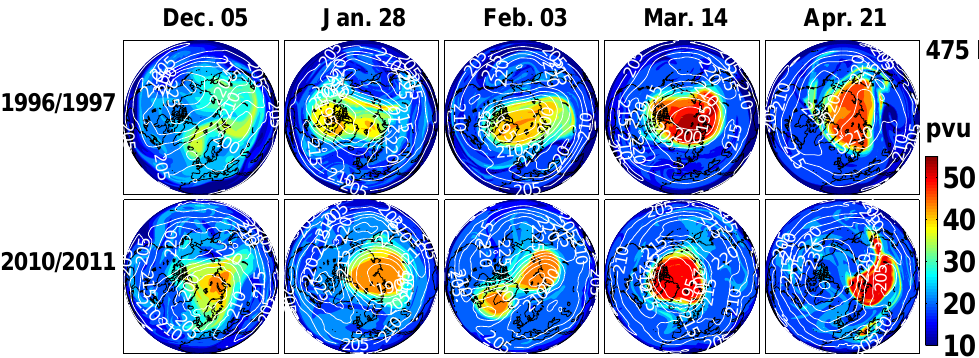
Fig. 2. Temporal evolution of the polar vortex during selected days of the Arctic winters 1996/1997 (upper panel) and 2010/2011 (lower panel) at 475K potential temperature level. The days are selected by analyzing the complete record of the winter to fairly represent the temporal evolution. The overlaid white contours are temperature in Kelvin. The blue/red colors show relatively low/high potential vorticity units (pvu), where 1pvu is 10 − 6 km 2 kg − 1 s − 1